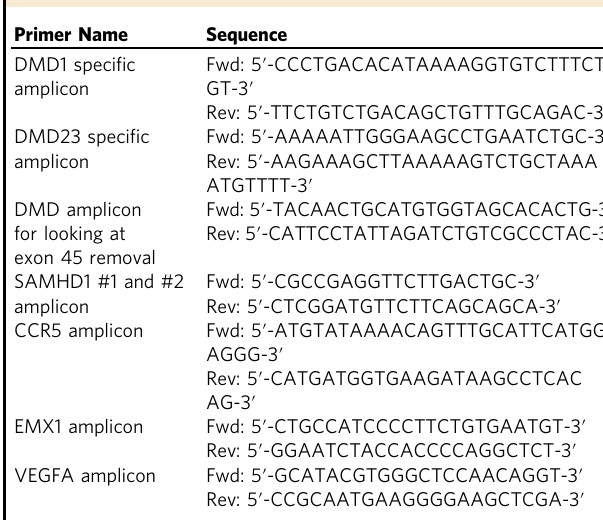
Table 5 Primers used for T7EI